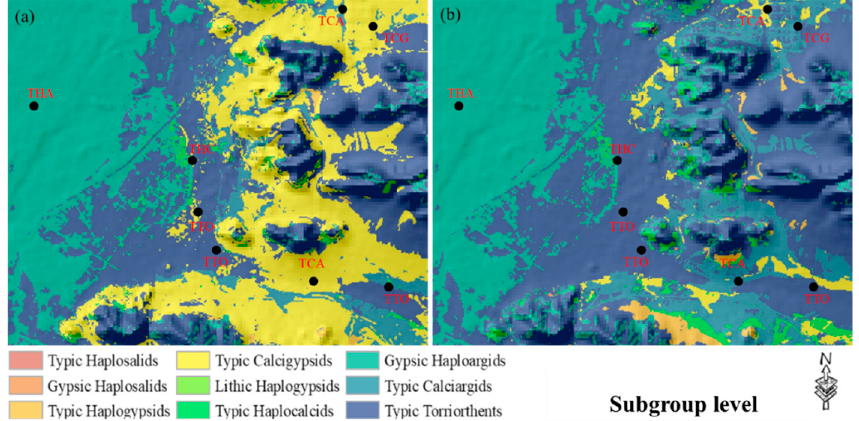
Figure 5. The spatial distribution of soil classes at Subgroup level in a smaller area using different spatial models: Random Forest ( a ) and Ensemble.2 ( b ). GHS: Gypsic Haplosalids; Lithic Haplogypsids: LHG; Typic Calciargids: TCA; Typic Calcigypsids: TCG; Typic Haploargids: THA; Typic Haplocalcids: THC; Typic Haplogypsids: THG; Typic Haplosalids: THS; Typic Torriorthents: TTO.